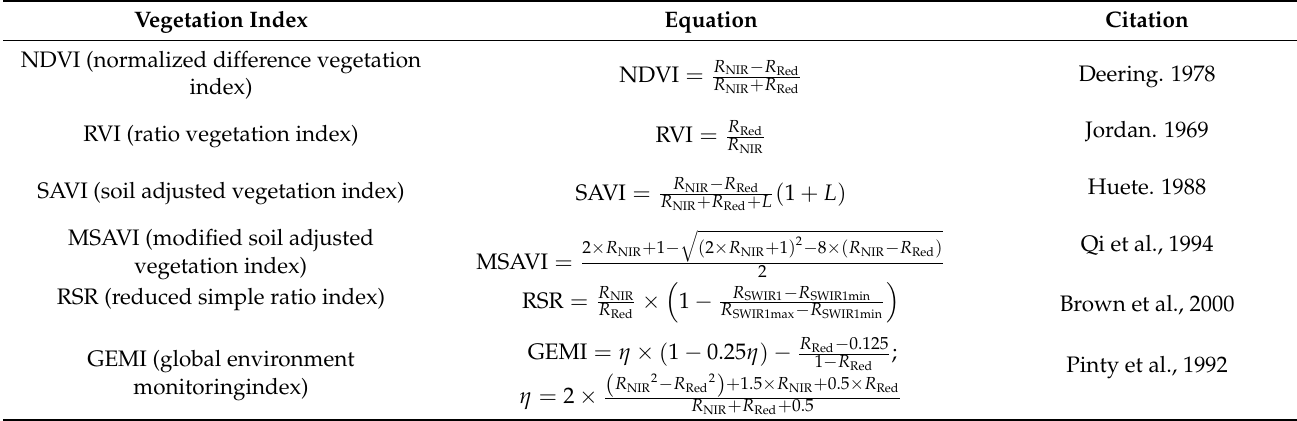
Table 1. The Sentinel-2-based multispectral photosynthetic vegetation indices (PVIs) used for the photosynthetic vegetation ( f PV ) estimation.